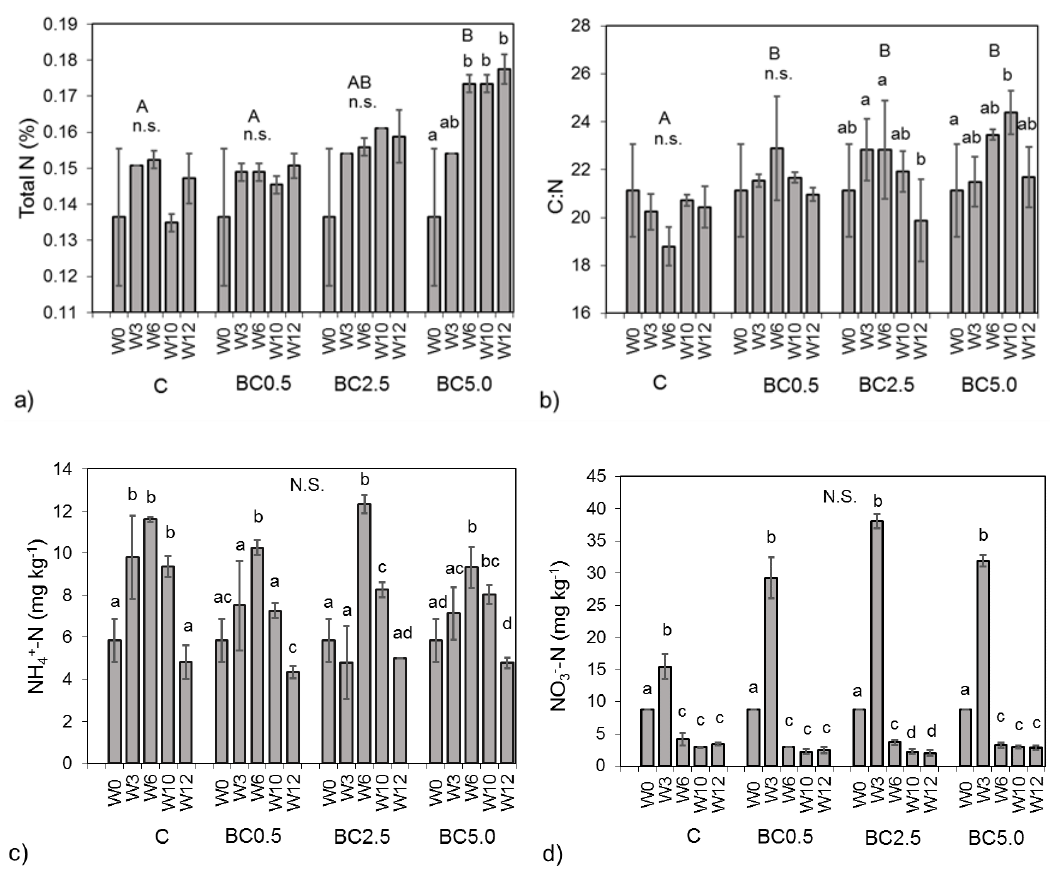
Figure 5. Soil nitrogen as ( a ) total N, ( b ) C:N ratio, ( c ) NH 4+ -N, and ( d ) NO 3 − -N, changes over the course of study. Error bars represent standard deviations between three replicates per treatment. Statistically significant differences ( p < 0.05) are indicated by different letters, while N.S. denotes not significant differences between treatments.